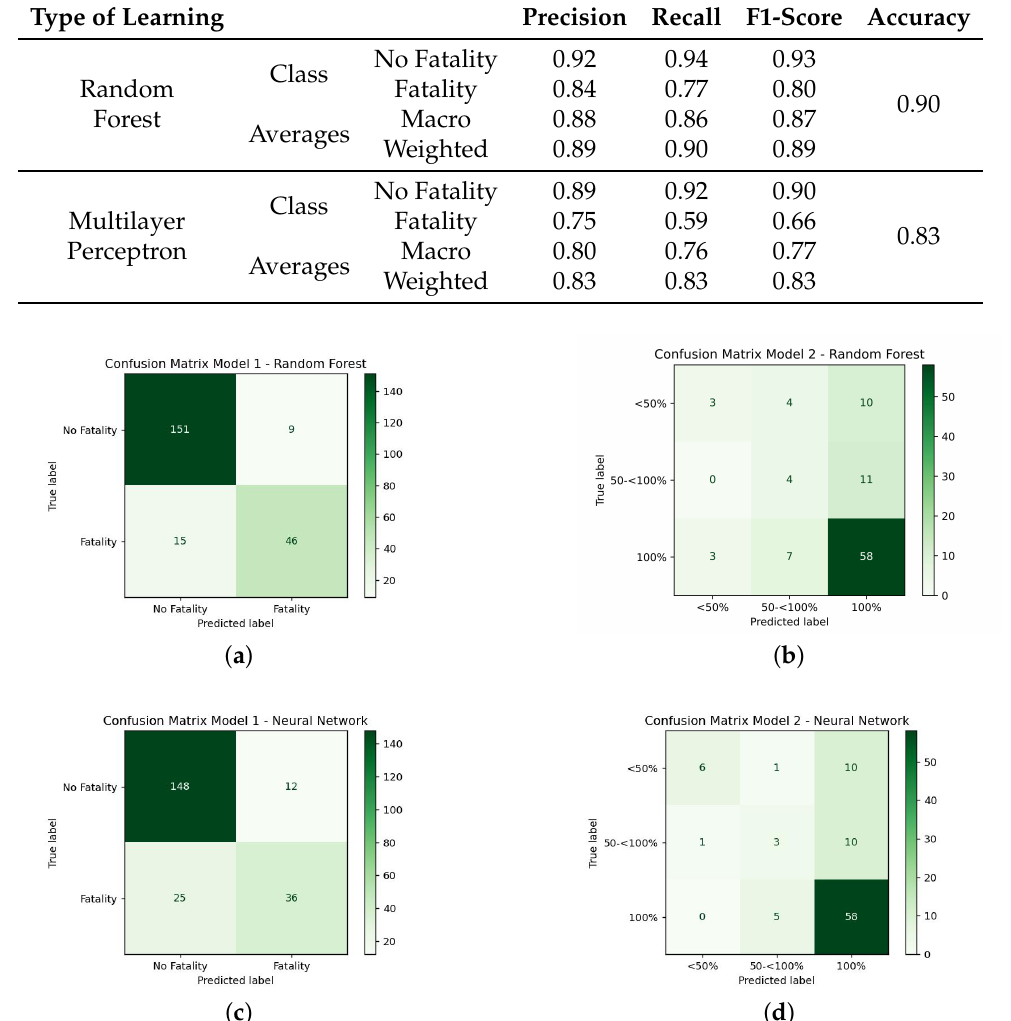
Figure 5. Confusion Matrixes for Model 1 (left) and Model 2 (right) with RF algorithm (top) and MLP algorithm (bottom). ( a ) Random Forest, Model 1. ( b ) Random Forest, Model 2. ( c ) Neural Network, Model 1. ( d ) Neural Network, Model